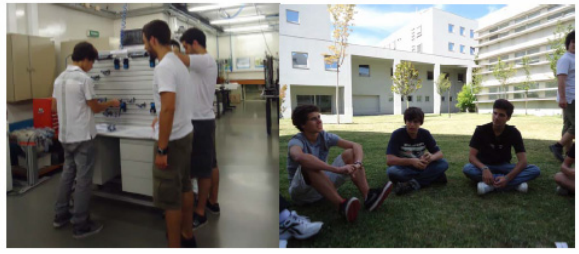
Figure 5. Hands-on activity and social